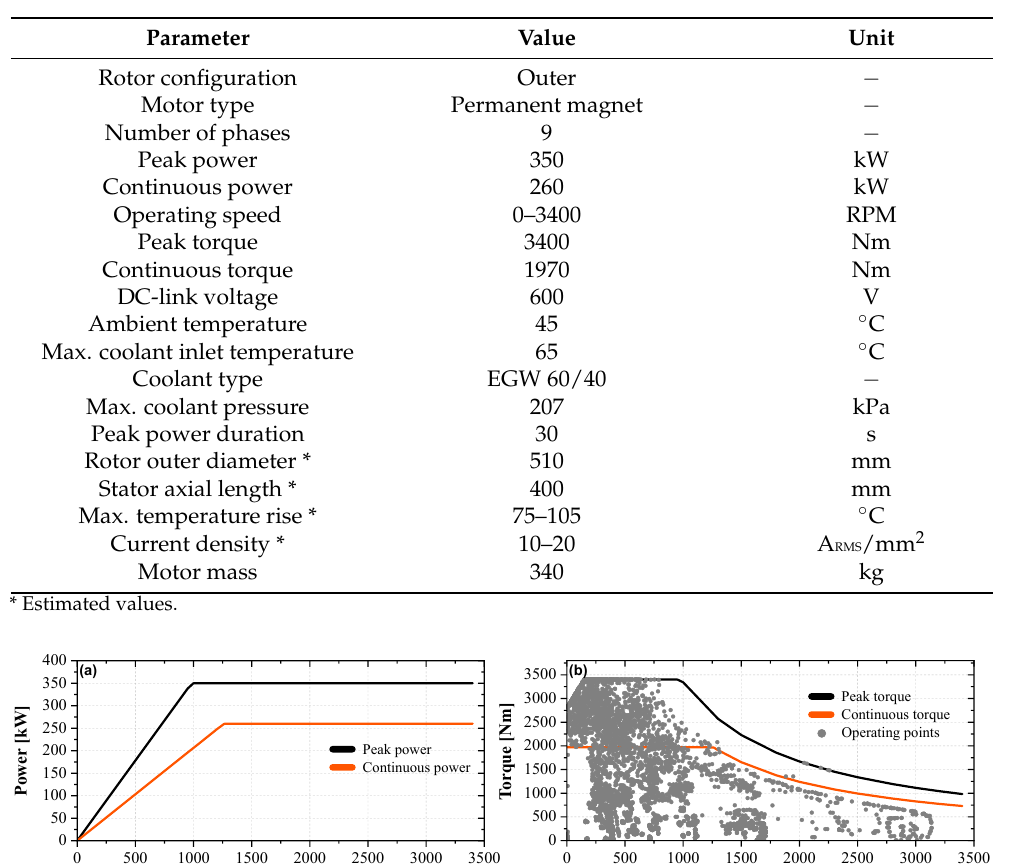
Table 2. TM4 SUMO HD HV3500-9P—Electrical and mechanical specifications [19,22].